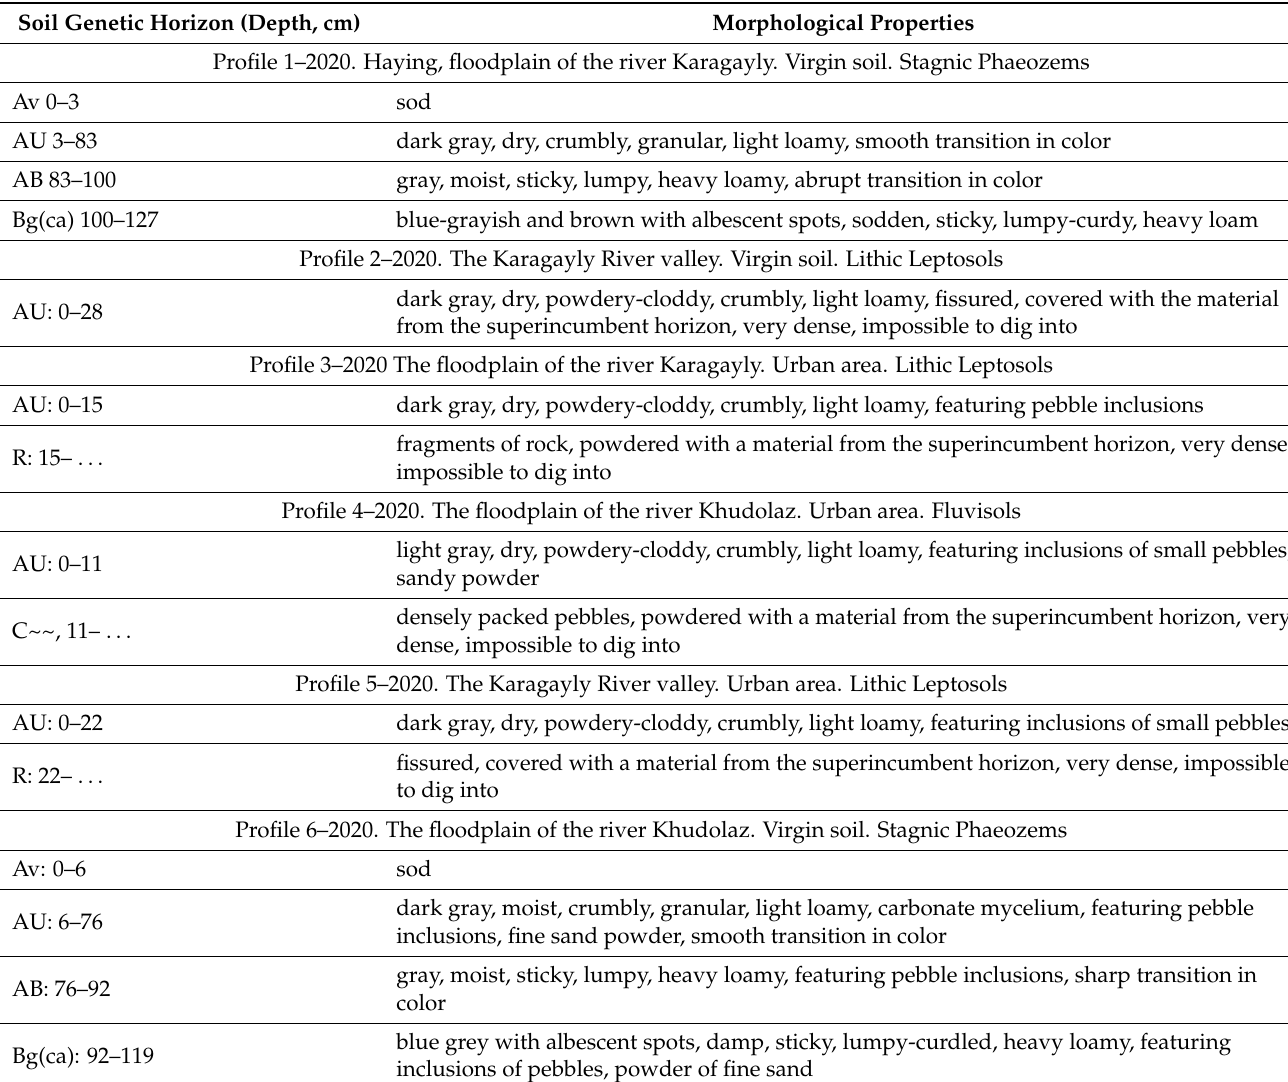
Table 2. Morphological description of the studied soils.